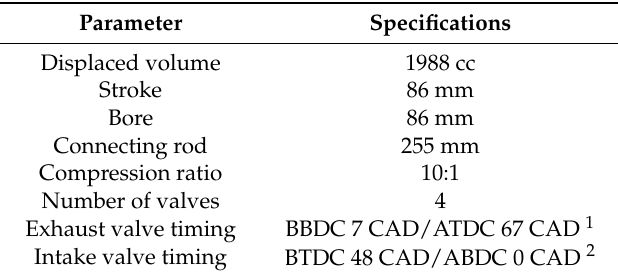
Table 1. Specifications of the test